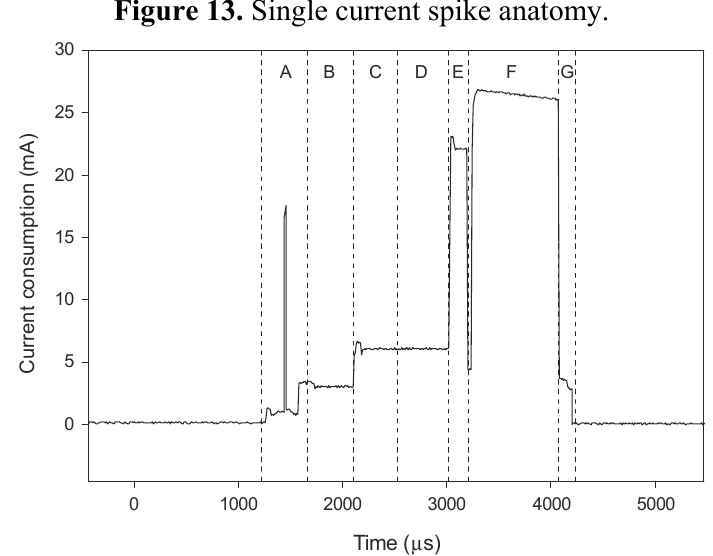
Figure 13. Single current spike